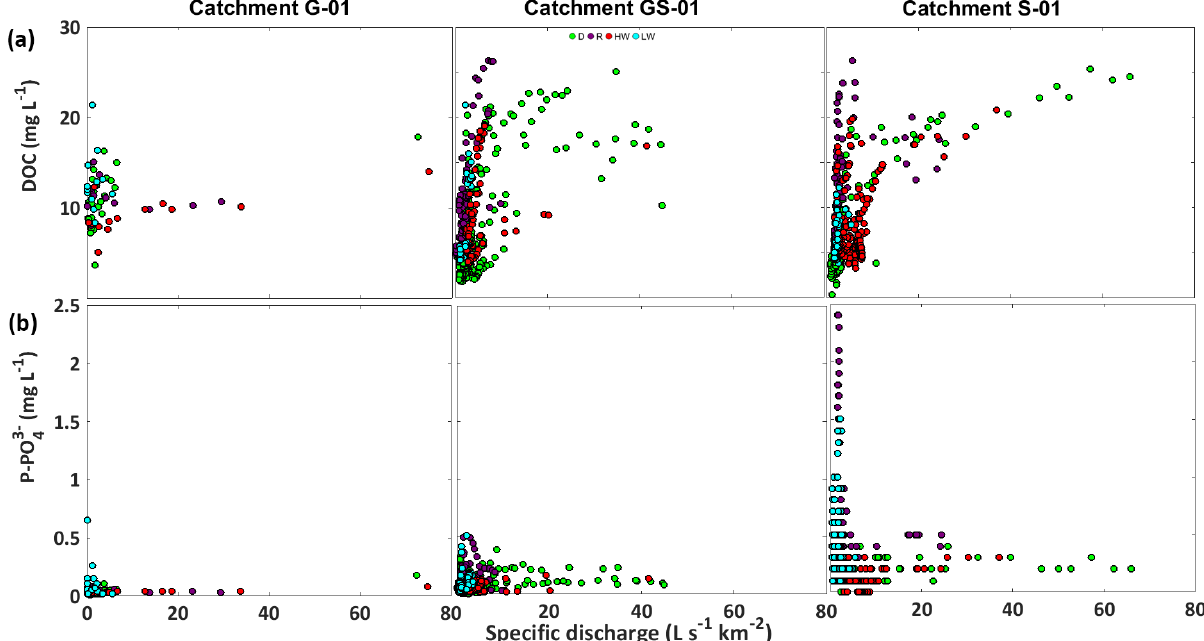
Figure 2. Relationship between specific discharge and (a) dissolved organic carbon, on the one hand, and (b) phosphate, on the other hand, for three headwater catchments (G-01, GS-01, and S-01) in Brittany, France. Chemistry data from daily automatic sampling supplemented by sub-daily sampling for catchments GS-01 and S-01 during discharge events (see methods for detailed sampling description). Data are colored by hydrologic period: D – discharge (April–June); LW – low water (July–September); R – recharge (October–December); HW – high water